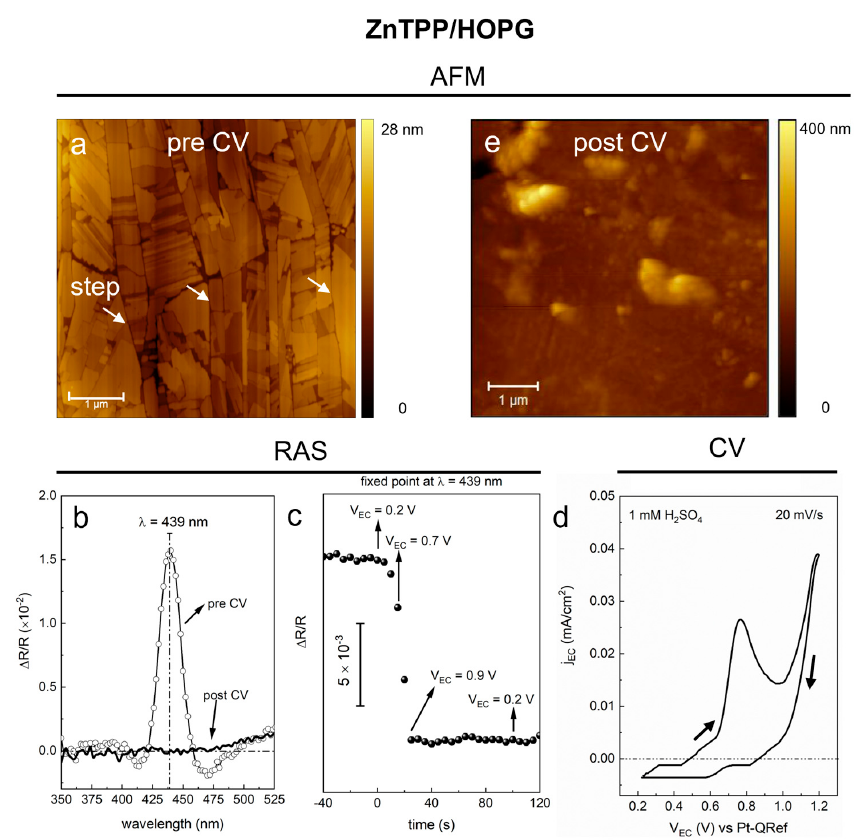
Figure 2. ( a ) (5 × 5) µ m 2 topographic image of a 6 nm thick ZnTPP/HOPG sample; white arrows points at some steps of the HOPG substrate. The AFM image was acquired ex situ on an as-deposited sample. ( b ) RAS spectra in the 350–525 nm range, acquired when the sample is in the EC cell filled with a 1 mM H 2 SO 4 solution. Spectra acquired before (line + symbol) and after (solid line) the CV are reported. ( c ) Real-time RAS monitoring of the Soret-related band intensity ( λ = 439 nm) during CV in a 1 mM H 2 SO 4 solution. The time axis is rescaled to show all the time range covered by the sweep of the EC potentials in the CV; time = 0 s corresponds to the starting point of the CV (V EC = 0.2 V); spectral points are collected every 5 s. The scale of the y-axis is showed by a vertical bar. Arrows and labels indicate the EC potentials reached during the CV. ( d ) Voltammogram obtained